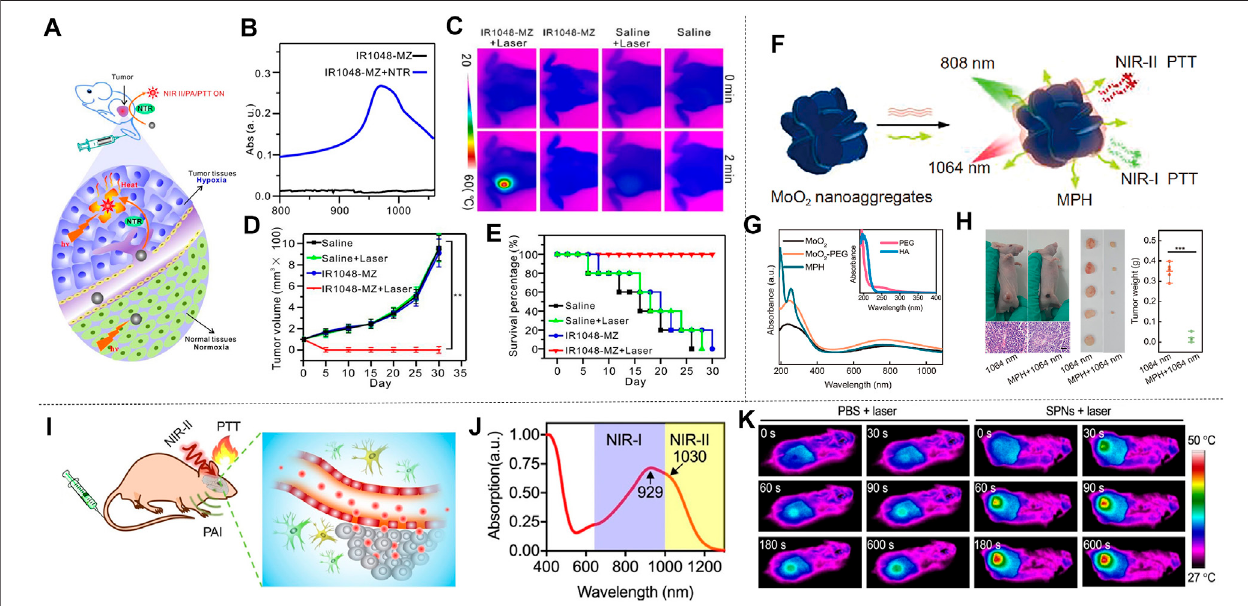
FIGURE 12 | PTT of lung cancer and glioma. (A) IR1048-MZ as a novel NTR enzyme response single-molecule probe for NIR- Ⅱ hypoxia-activated PTT. (B) The absorption spectrum of IR1048-MZ when NTR is absent (black) and when NTR is present (blue). (C) Infrared thermal images of lung tumor-bearing mouse injected with saline or IR1048-MZ with or without 980 nm NIR laser irradiation (0.1 W cm − 2 ) for 2 min. The room temperature is 23 ˚ C. (D) Lung tumor growth curve after 30 days of differenttreatments. (E) Survivalrateoflungtumor-bearingmiceaftervarioustreatments( n (cid:2) 5)(reproducedfrom(Mengetal.,2018)withpermissionfromIvyspring International Publisher). (F) Schematic diagram of NIR response to MoO 2 nano-aggregates and their PTT applications. (G) UV-vis-NIR absorption spectrum of MoO 2 nano aggregate surface-modi fi ed. (H) lung-tumor-bearing mouse and it ’ s tumors dissected after treatment, and tumor weights after 16 days of treatment ( n (cid:2) 5) (reproduced from (Guo, et al., 2020) with permission from Science China Press and Springer-Verlag GmbH Germany,part ofSpringerNature). (I) Schematic diagram of SPNs used in NIR- Ⅱ photothermaltreatmentofbrain tumors. (J) Absorptionspectraof SPNs inaqueousdispersion. (K ) Theinfrared thermal image ofthemouse during the 10-min PTT (1,064 nm, 1 W cm − 2 ). Mice treated with PBS + laser were used as controls (reproduced from (Wen, et al., 2020) with permission from American Chemical